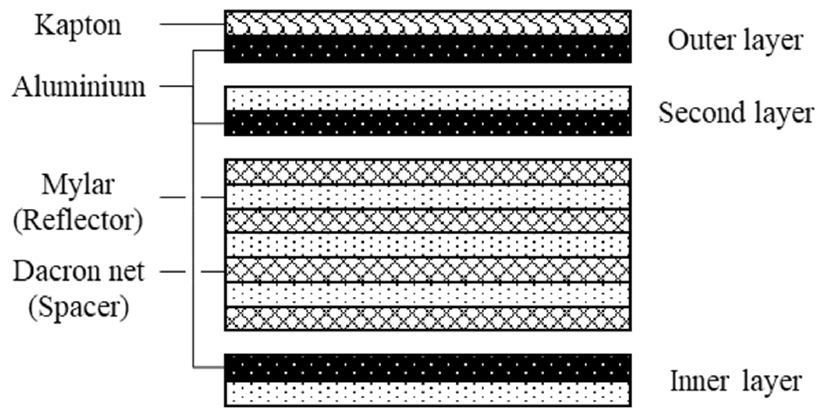
Figure 3. MLI configuration for insulating spacecraft [20].